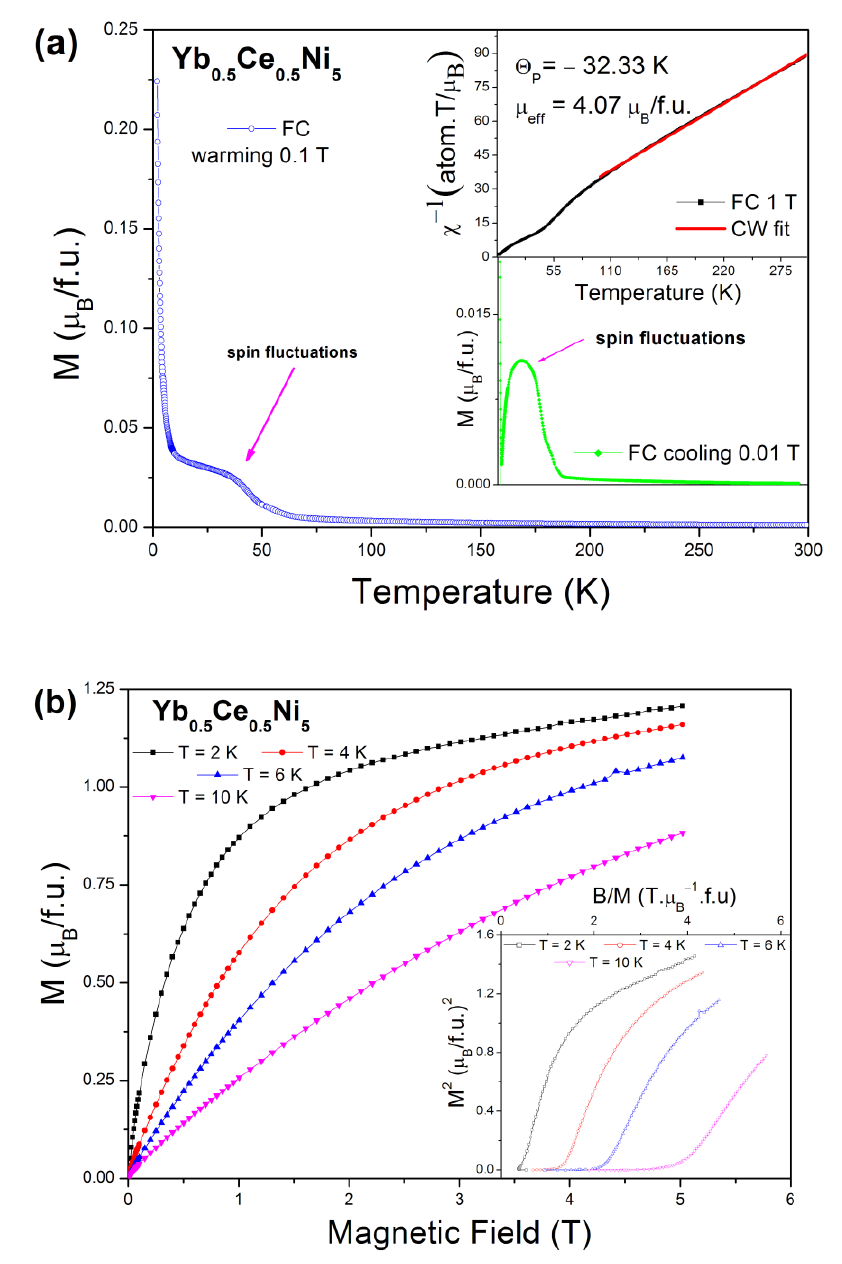
Figure 2. ( a ) Temperature dependence of the magnetization at 0.1 T and 0.01 T (down inset). Maxi- mum at T = 40 K connected with spin fluctuation is visible. The top inset presents the inverse of the magnetic susceptibility fitted to the Curie-Weiss law. ( b ) Characteristic behavior of the magnetic field dependence at very low temperatures of magnetization for the Yb 0.5 Ce 0.5 Ni 5 compound. The inset shows Arrott plots of M 2 vs. B/M for the studied material. If we consider the trends of lattice parameters from YbNi 5 (a = 0.4841–0.4850 nm, c = 0.3957–0.3968 nm) and CeNi 5 (a = 0.4870–0.4890 nm, c = 0.4000–0.4013 nm), it can be determined that the lattice parameters of Yb 0.5 Ce 0.5 Ni 5 are in between the